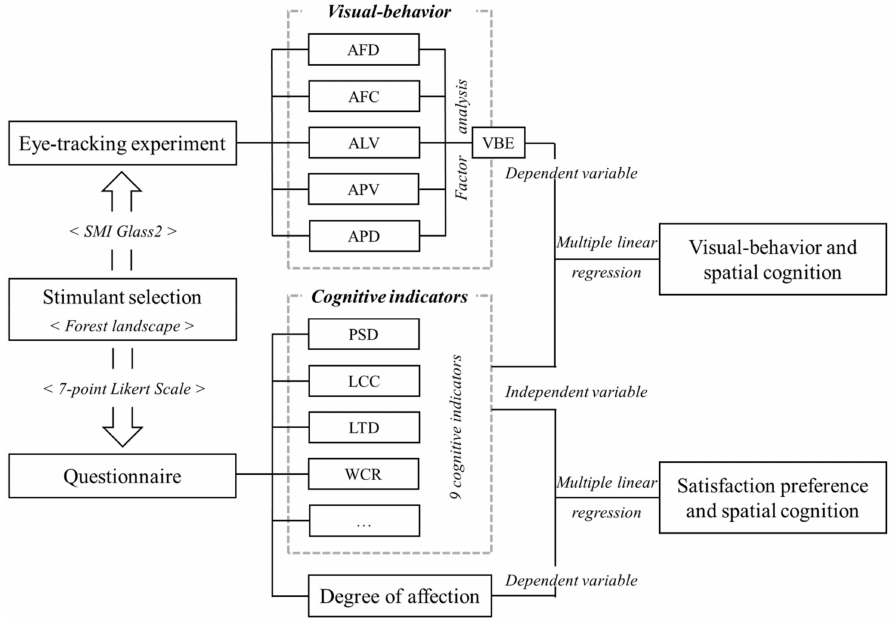
Figure 4. Research framework. Note: AFD: average fixation duration; AFC: average fixation count; ALV: average lateral visual span; APV: average portrait visual span; APD: average pupil